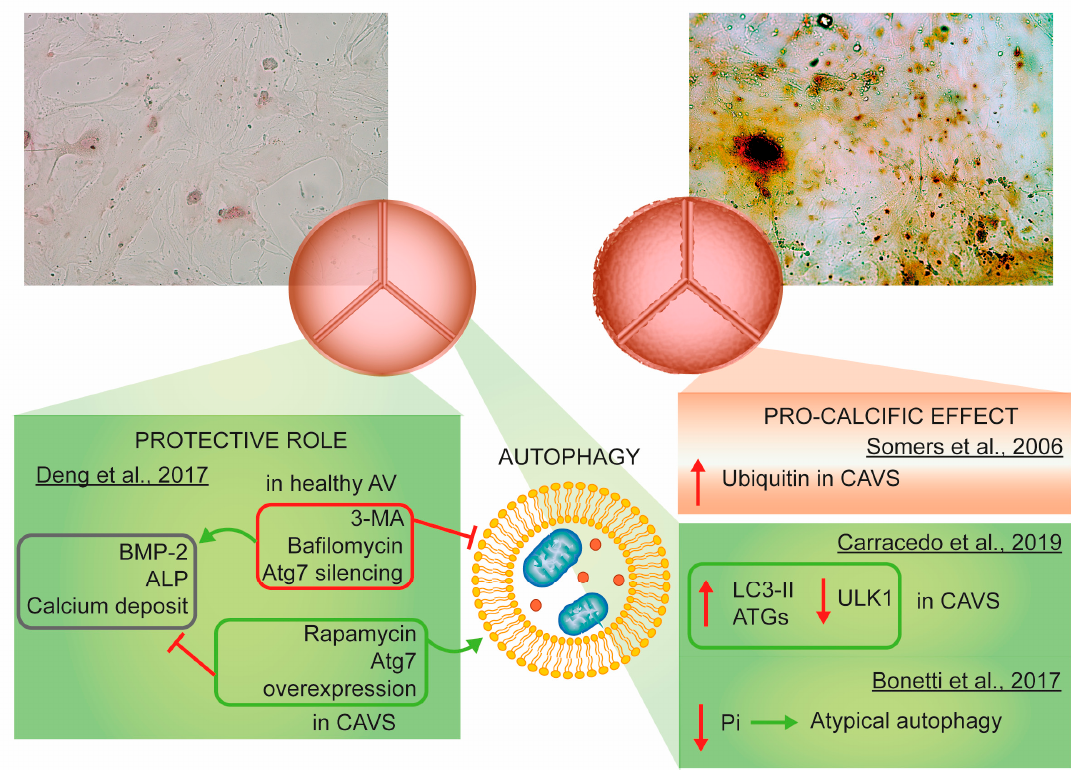
Figure 3. Autophagy involvement in aortic stenosis. Immunohistochemical alizarin red staining was used to identify calcium deposits in the human aortic valve interstitial cells. The autophagic process has been associated with the calcification of aortic leaflets by several independent works, but no definitive results have been achieved. Abbreviations: AV, aortic valve; BMP-2, bone morphogenetic protein-2; ALP, alkaline phosphatase; 3-MA, 3-methyladenine; Atg7, autophagy-related 7; CAVS, calcific aortic valves; LC3-II, microtubule-associated protein 1A / 1B light chain 3; ULK1, unc-51-like kinase; Pi, inorganic phosphate.